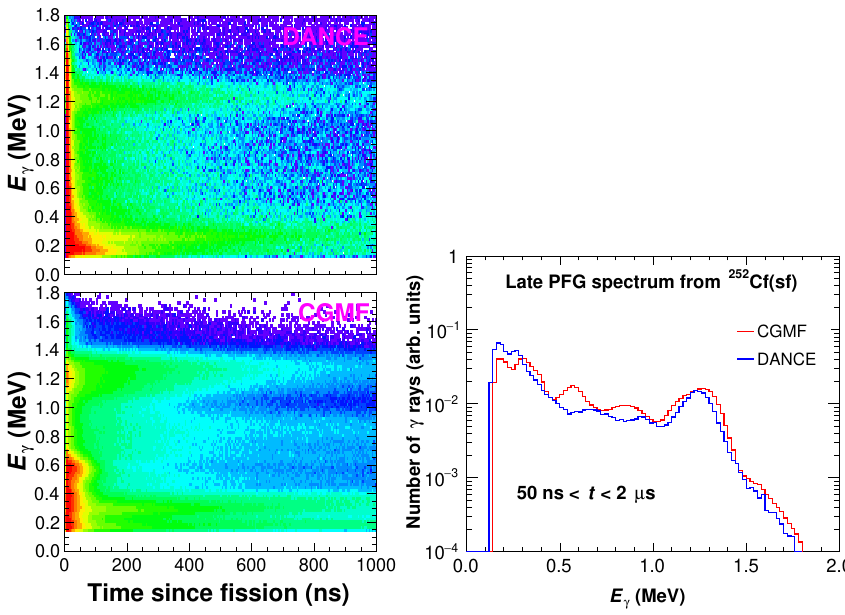
Figure 6. The same as Fig. 5, but for the late PFG from 252